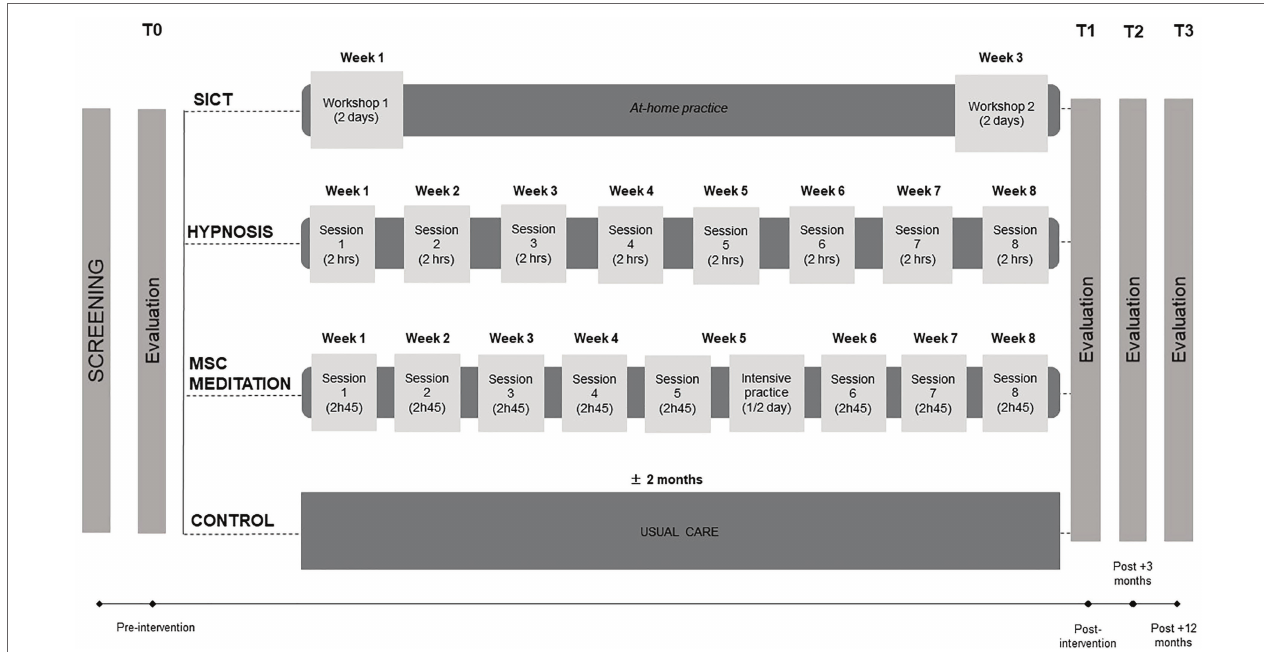
FIGURE 1 | Study design. SICT, self-induced cognitive trance; MSC, mindful self-compassion; hrs,